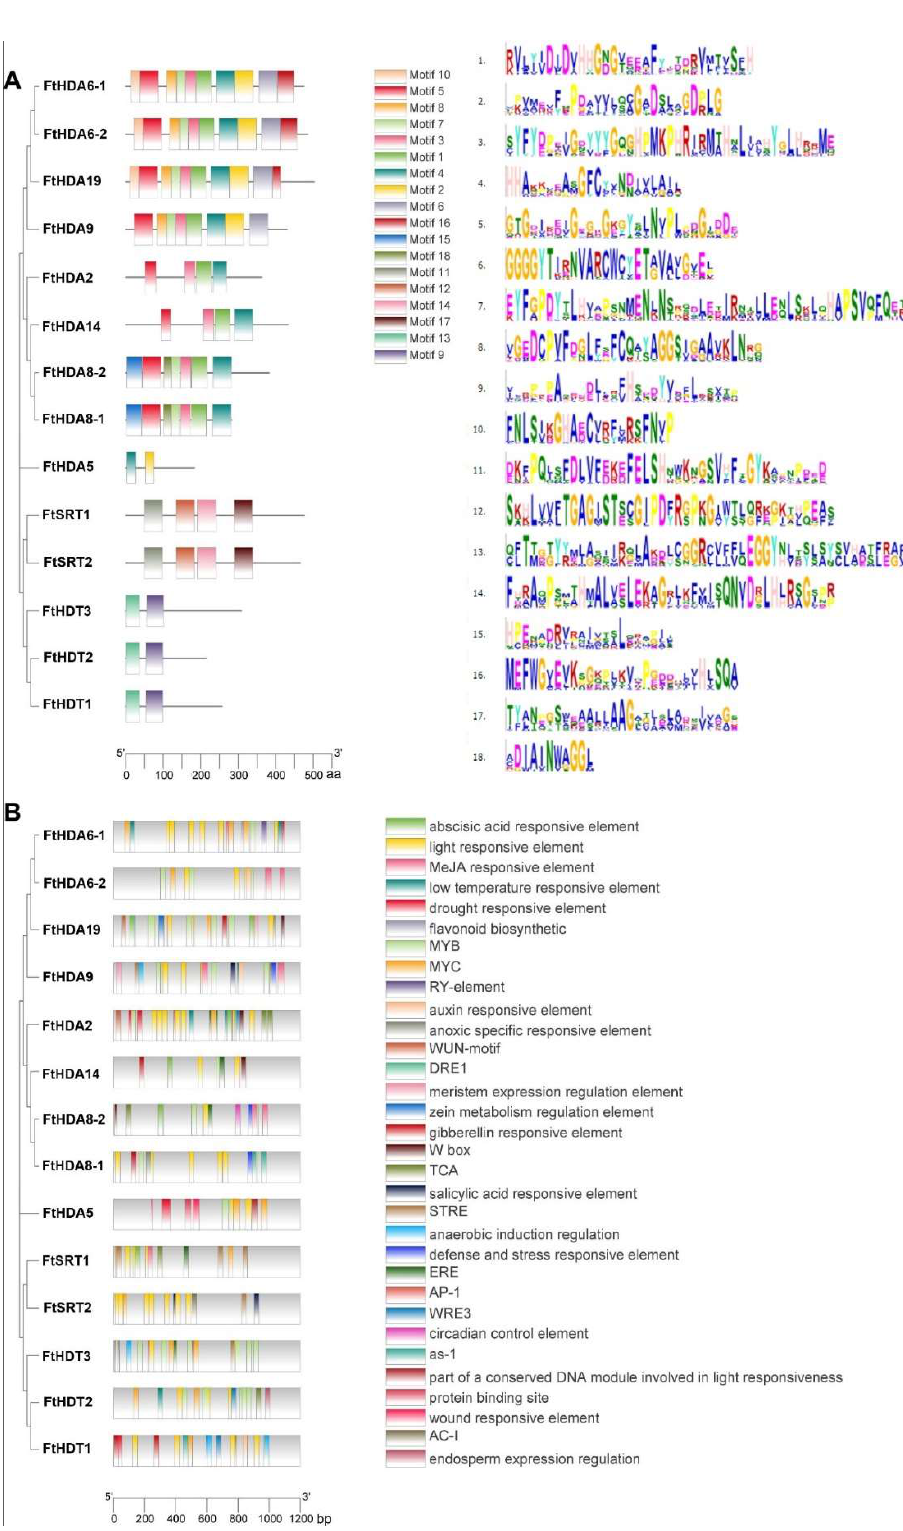
Figure 2. Conserved protein structure and cis-acting element prediction of FtHDACs. ( A ) Conserved motifs of FtHDACs proteins using MEME, and details of the 18 conserved motifs shared among the FtHDACs proteins. Each motif is indicated by a colored box numbered on the right. The length of the motifs in each protein is shown as a proportion. Motif symbol and motif consensus also are shown. ( B ) Cis-acting element prediction via PLANT CARE. There are 32 types of cis-elements, marked with rectangles of different colors.